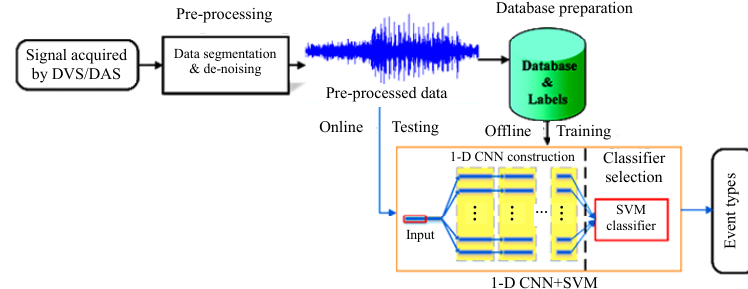
Fig. 34 Proposed 1-D CNN-SVM